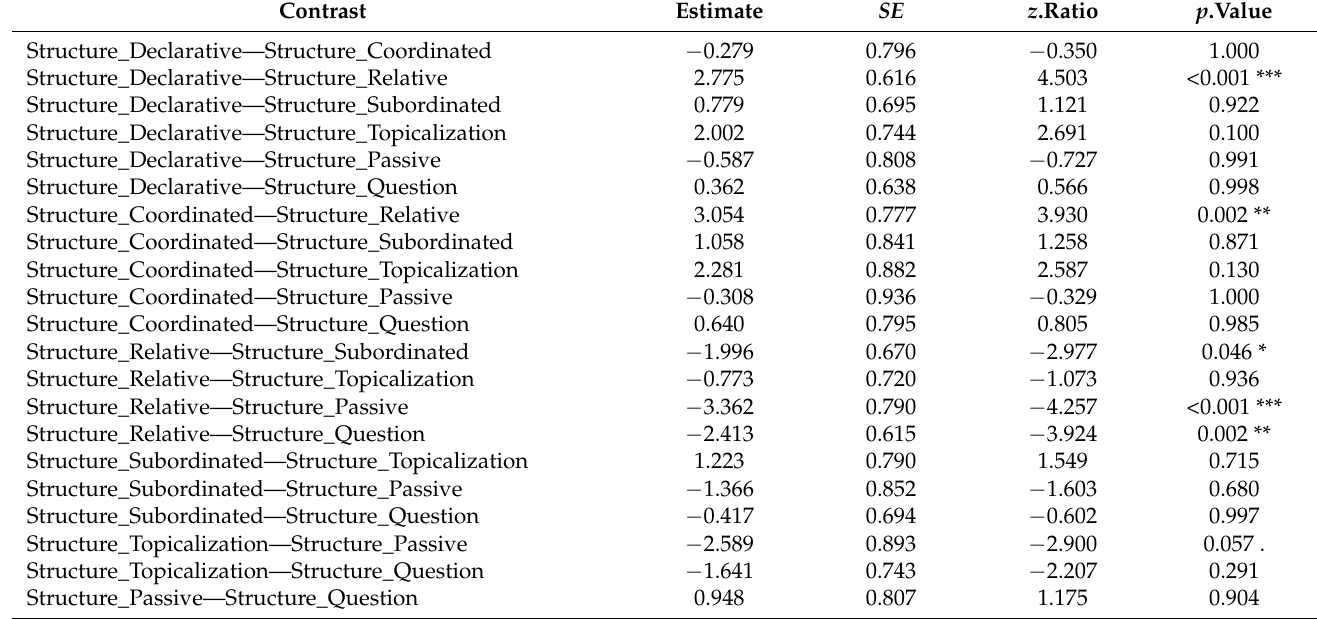
Table A12. Post-hoc tests with a Tukey adjustment showing pairwise contrasts by morphosyntactic structure in Syrian Arabic T1